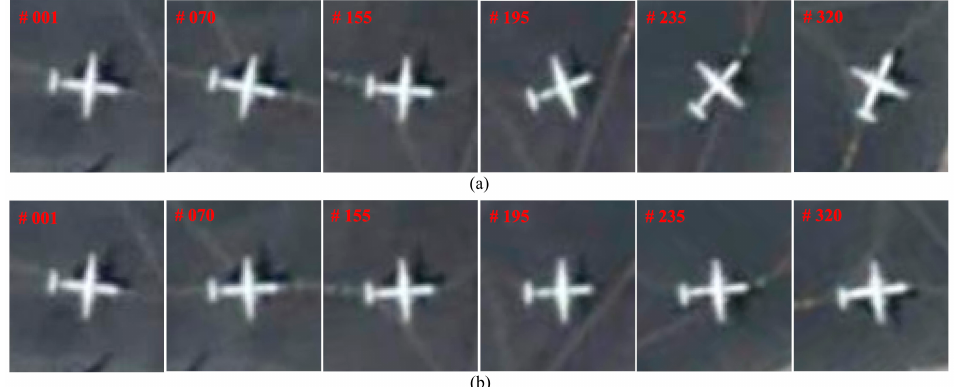
Figure 12. Visual comparison of original patches ( a ) and rotated patches ( b ).